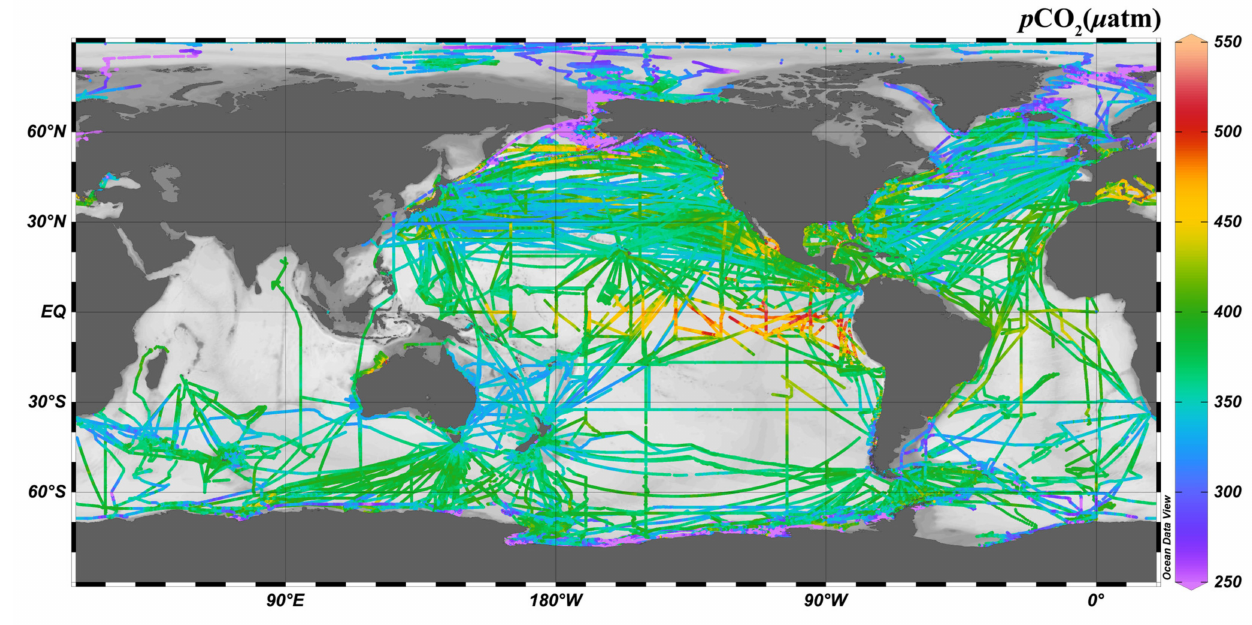
Figure 1. Spatial distribution of the LDEO p CO 2 dataset (2004–2019).